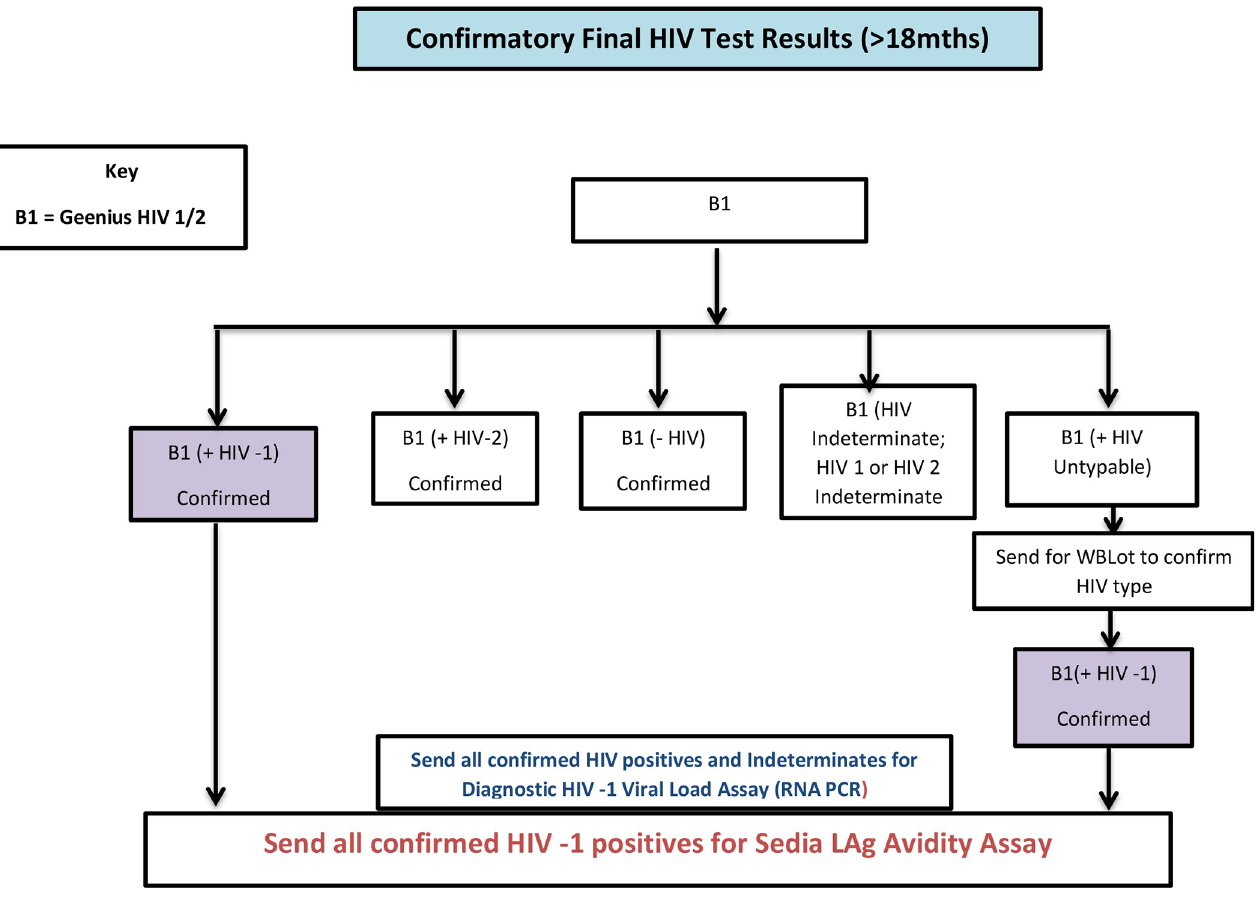
Fig 2. Confirmatory HIV testing algorithm ( > 18mnths), AKAIS 2017.